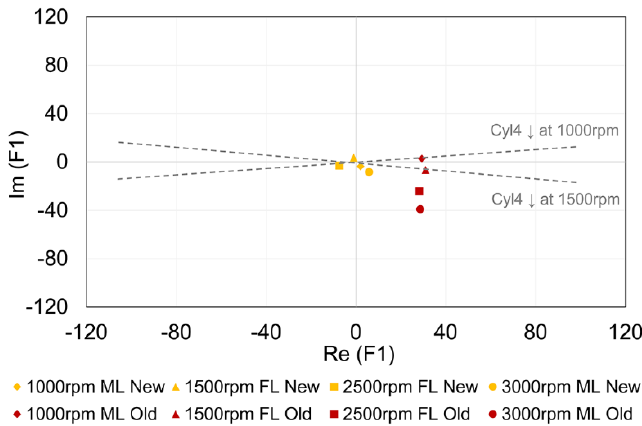
Figure 19. Representation in the complex plane of the first order (F1). Comparison between the new set of injectors (New) and the old one (Old) at different engine operating conditions: 1000 rpm at medium load (ML), 1500 rpm at full load (FL), 2500 rpm at full load (FL), and 3000 rpm at medium load (ML).